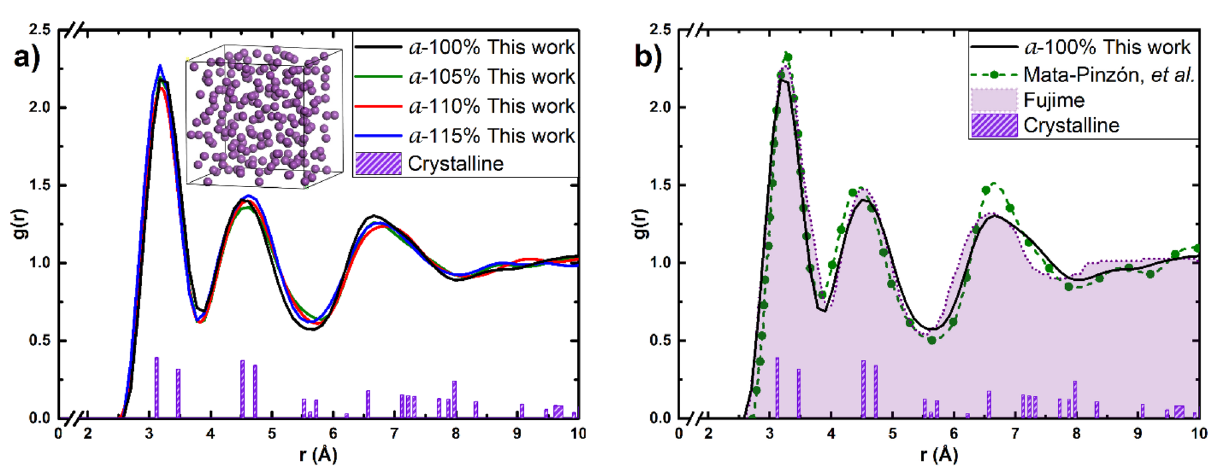
Figure 2. ( a ) PDFs for the amorphous supercells generated from the non-expanded and the expanded structures, at the end of the GO process. The 216-atom a-Bi 100% supercell is shown in the inset. ( b ) Comparison with the simulational results of Mata-Pinzón et al. 10 and the experiment reported by Fujime 12 . The crystalline non-expanded PDFs are also included for